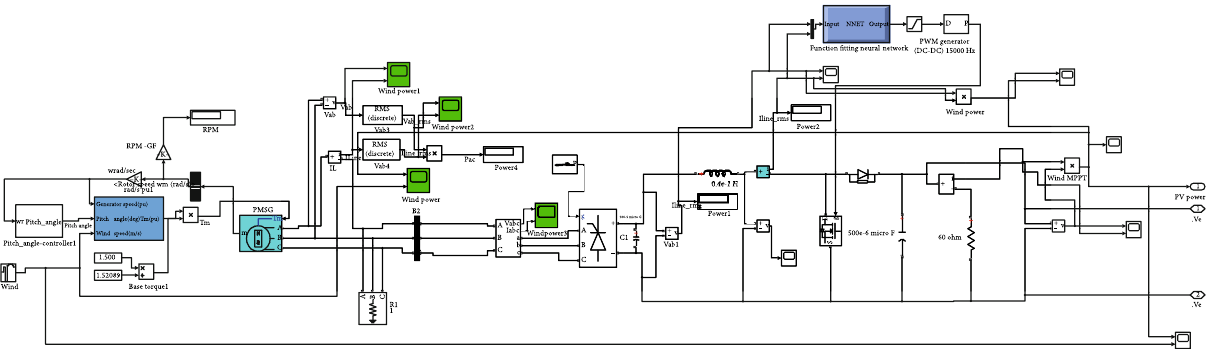
Figure 12: Simulation model of DNN controller-based MPPT algorithm (wind energy system).